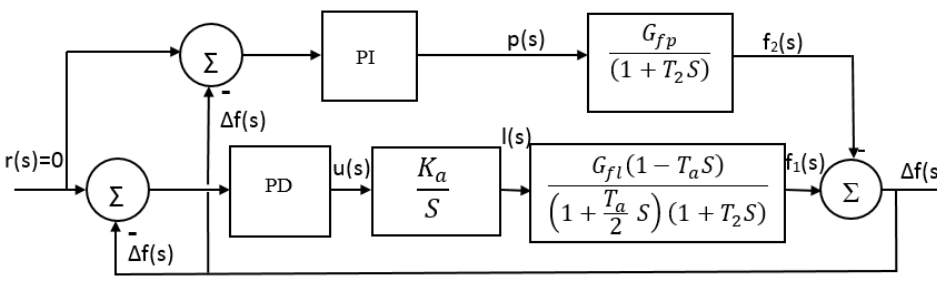
Figure 3. Block diagram of the combined control system.